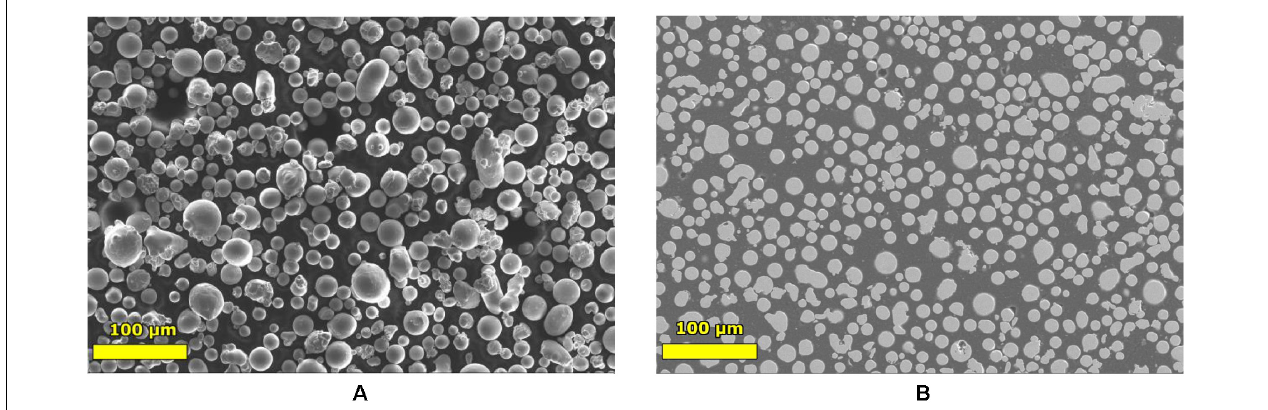
FIGURE 1 | SEM micrographs of (A) the AlCrFe 2 Ni 2 prealloyed powder particles and (B) cross-section of powder particles.